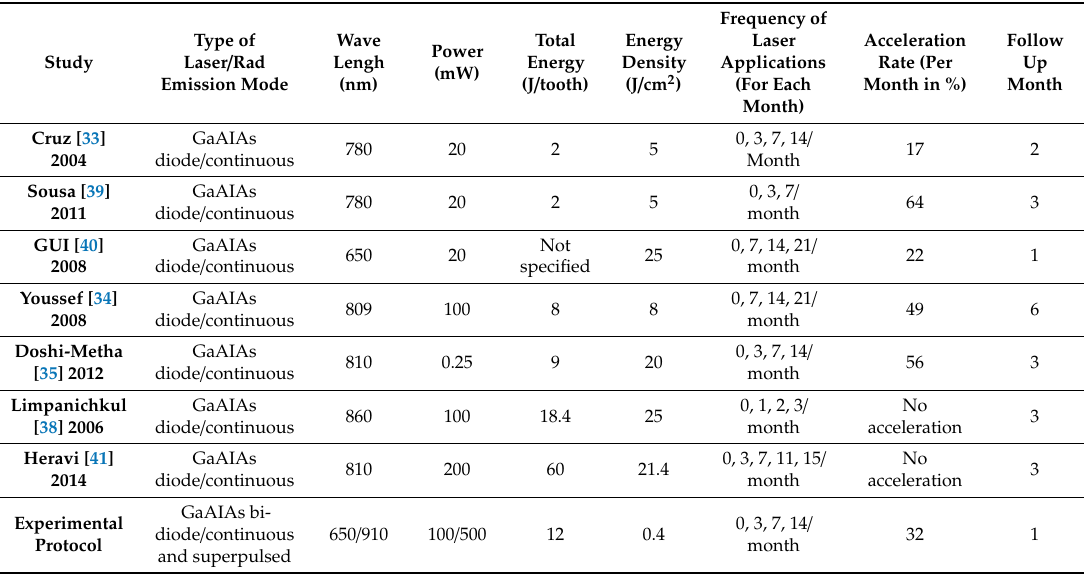
Table 4. Analysis of the